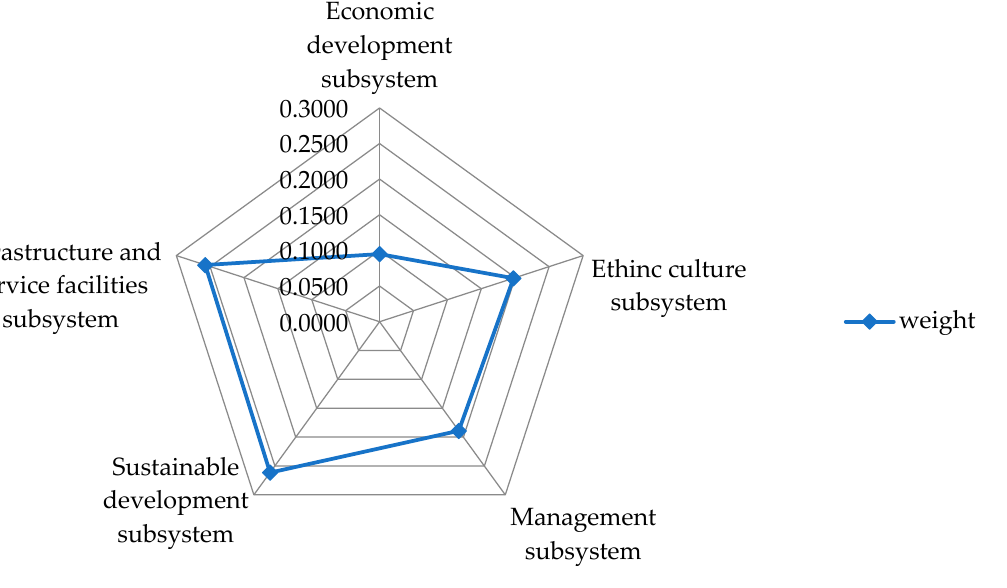
Figure 1. Criterion layer weight radar